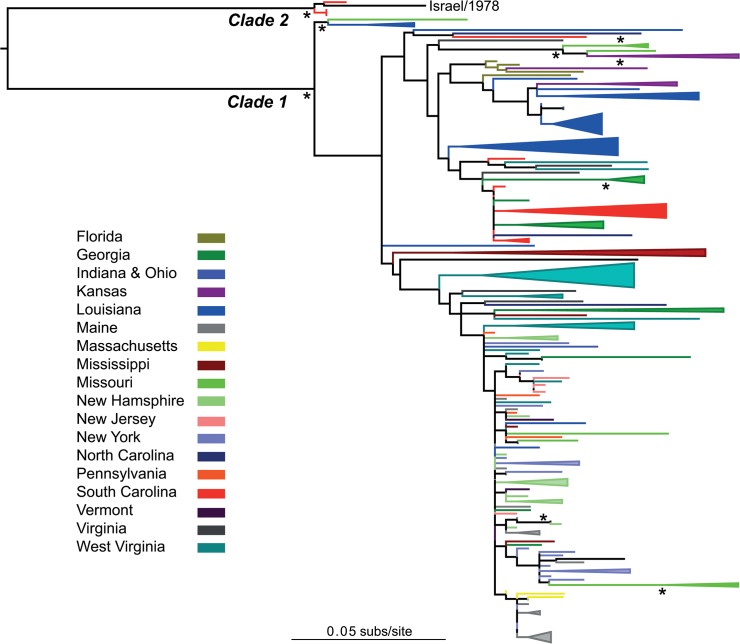
Phylogenetic relationships of LPDV sampled from wild turkeys in the United States of America.Sequences are color-coded according to the US state of isolation (see key), with viral sequences from the same state that form monophyletic groups “collapsed” and shown as triangles (the size of the triangle is a function of the number of sequences in the group). All branch lengths are scaled according to the number of nucleotide substitutions per site, and the tree is mid-point rooted for clarity only. Bootstrap support values >70% are shown by the * symbol.